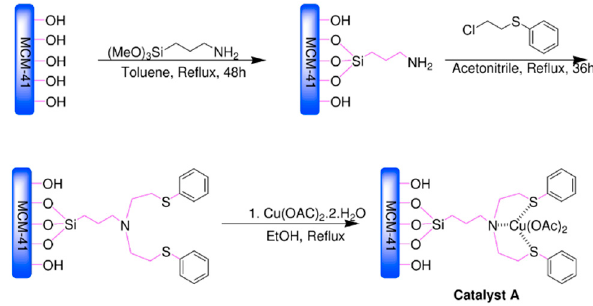
Figure 23. Synthesis of MCM-41@Serine@Cu(II). Reproduced with permission from [31]. Copyright 2018 Springer.